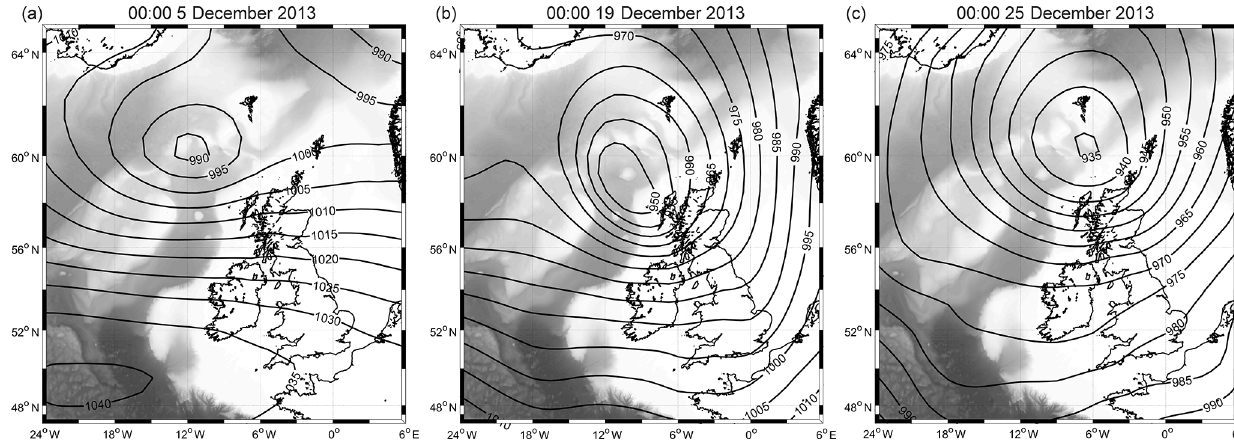
Figure 9. Sea level pressure maps for the three storm events associated with the winter 2013–2014 high-salinity pulse (HSP). These storms were named Xaver, Bernd, and Dirk, respectively. Sea level pressure data derived from the ECMWF ERA-Interim 0 . 75 ◦ × 0 . 75 ◦ product. Bathymetry contours from GEBCO bathymetry (http://www.gebco.net/, last access: 24 July 2017).